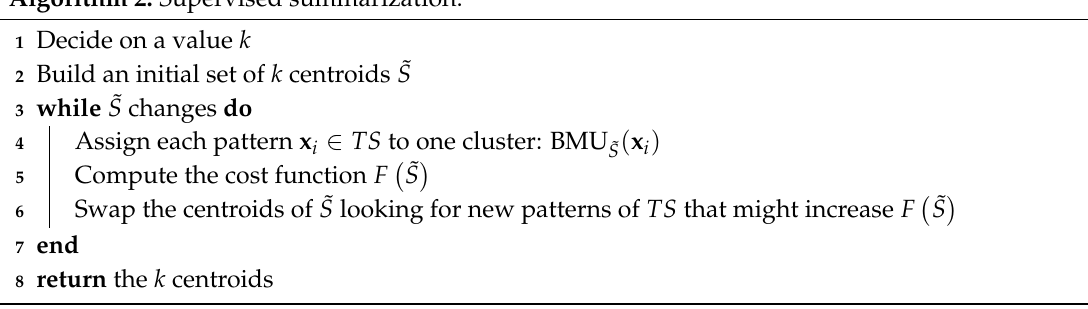
Algorithm 2: Supervised